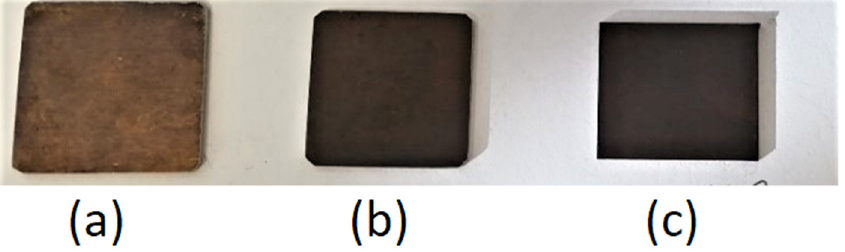
Figure 4. Image of samples treated with solution 2 with different immersion times: ( a ) 30 min, ( b ) 60 min, ( c ) 100